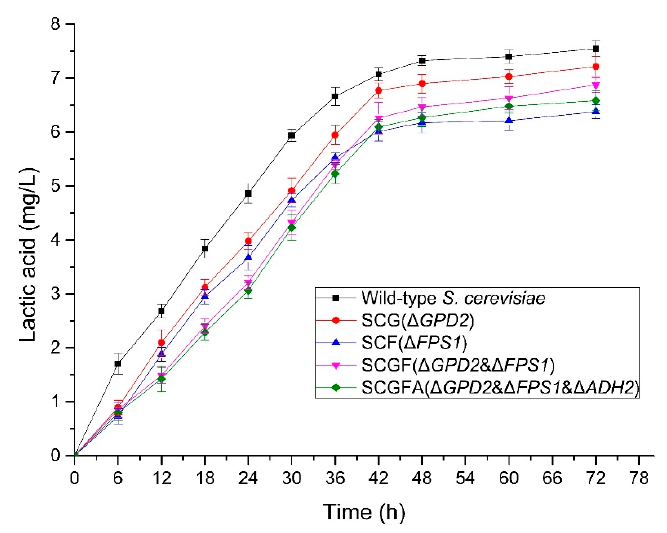
Figure 7. Gene deletion affecting the contents of lactic acid of S. cerevisiae .